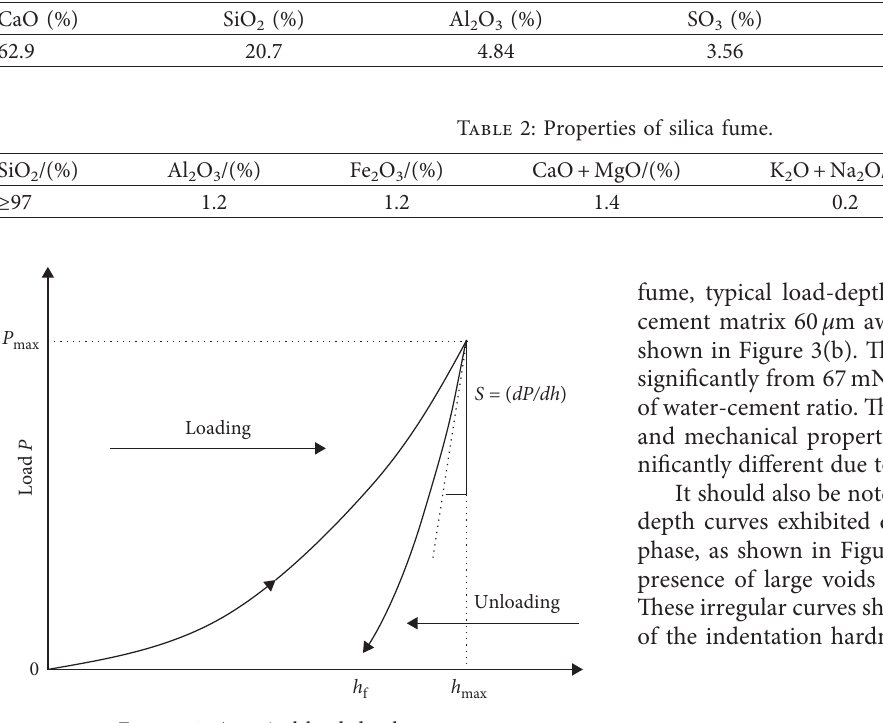
Table 1: Chemical composition of ordinary Portland cement.